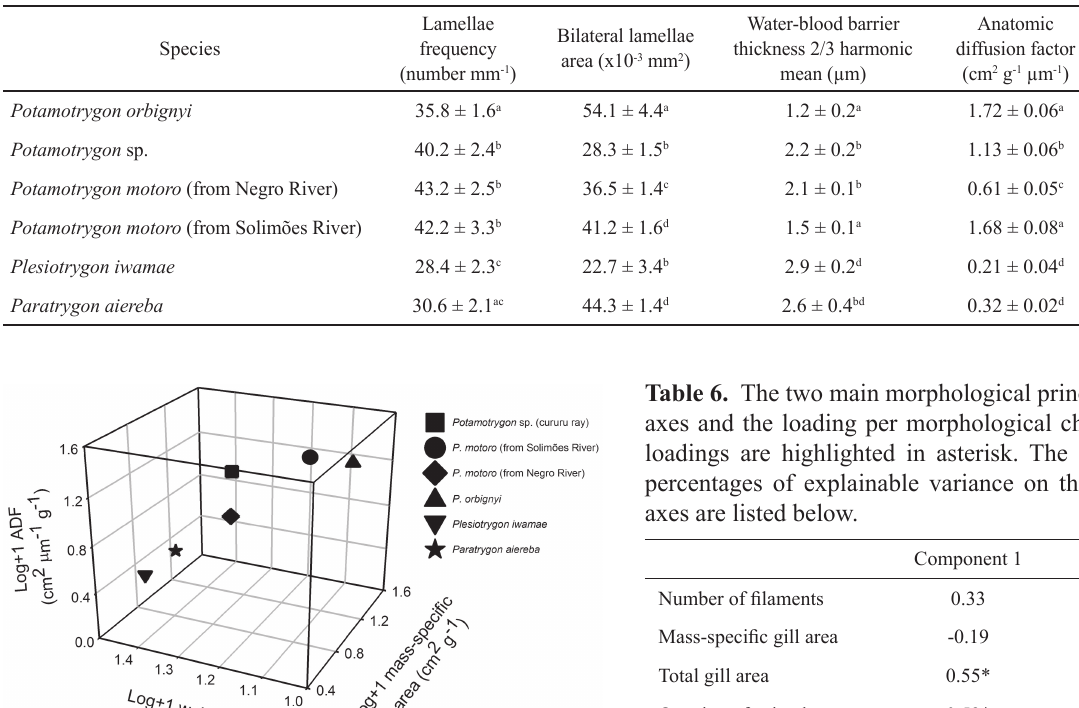
Table 5. General gill dimensions (mean ± S.E) in potamotrygonid embryos. † Both sides of the animal. Different letters indicate a significant difference (p < 0.05) between potamotrygonid species.